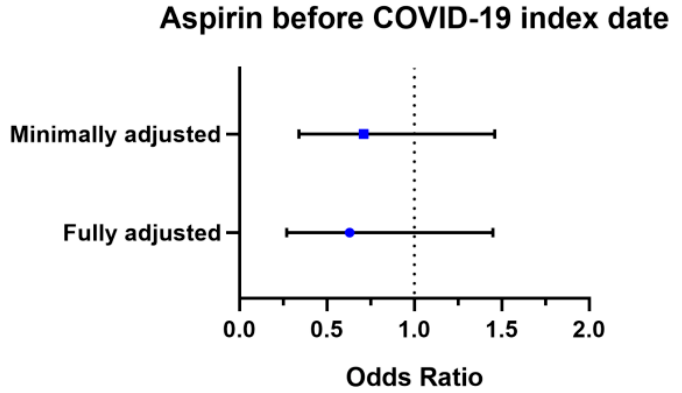
Figure 2. Forest plot of the association between aspirin and COVID-19 test positivity. Table 3. Difference of COVID-19 diagnosis between non-aspirin and aspirin users before COVID-19